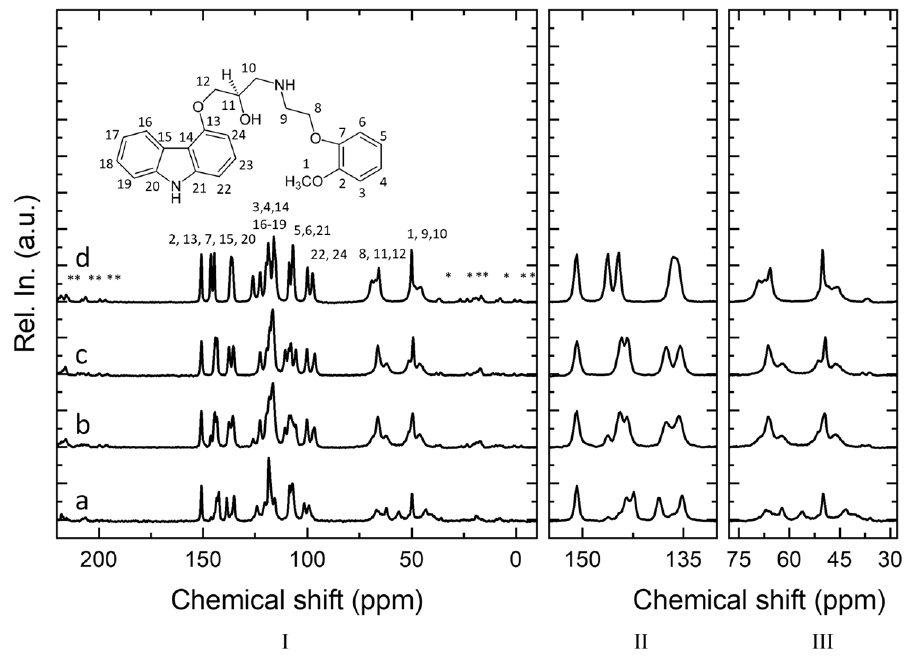
Figure 5. The 13 C NMR spectra of CH_H 2 SO 4 _0.5M (a), CH_HCl_8M (b), CH (c), and C (d) with attribution for the C sample in the 200-0 ppm range ( I ) and zoom in the 155-130 ppm range ( II ) and in the 75–30 ppm range ( III ) to highlight the regions presenting the more significant changes. The symbol * marks a spinning sideband.